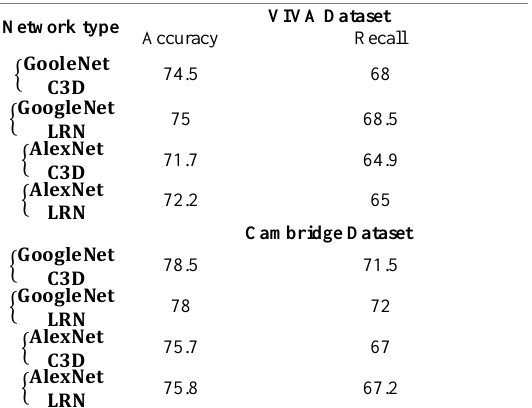
Table 8. Results for the final two-stream method. VIVA Dataset Network type Accuracy